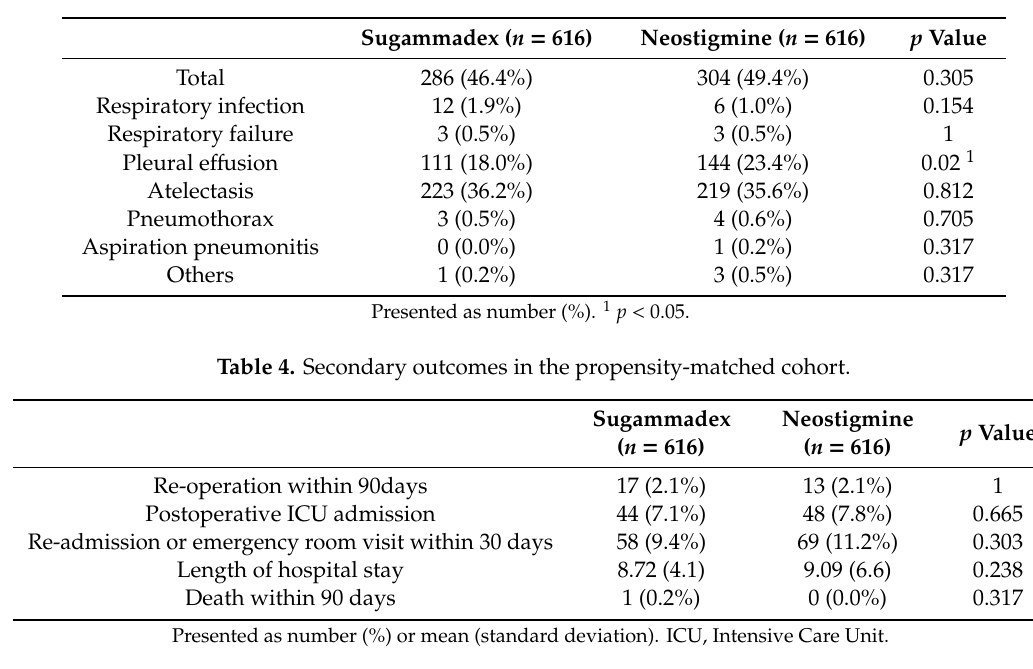
Table 3. Postoperative pulmonary complication rate in the propensity-matched cohort.